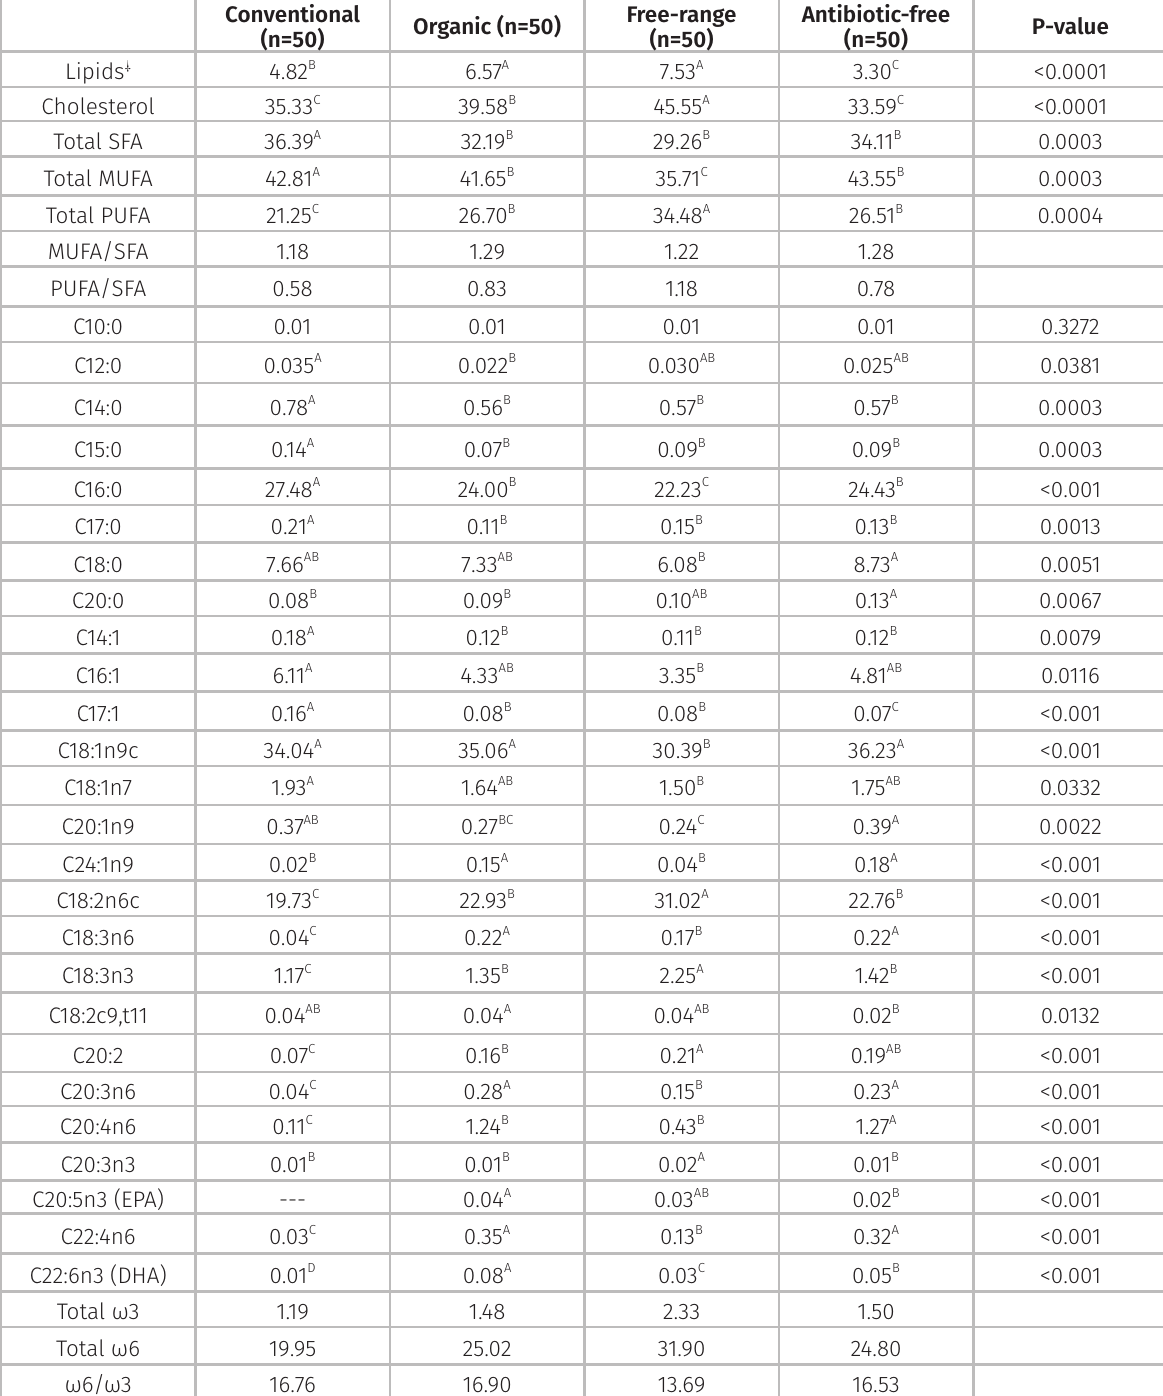
Table III. Lipids (%) and cholesterol (mg/100g) of thigh meat and fatty acid composition (% of total fatty acids) of fat from thigh meat from broilers raised in different rearing